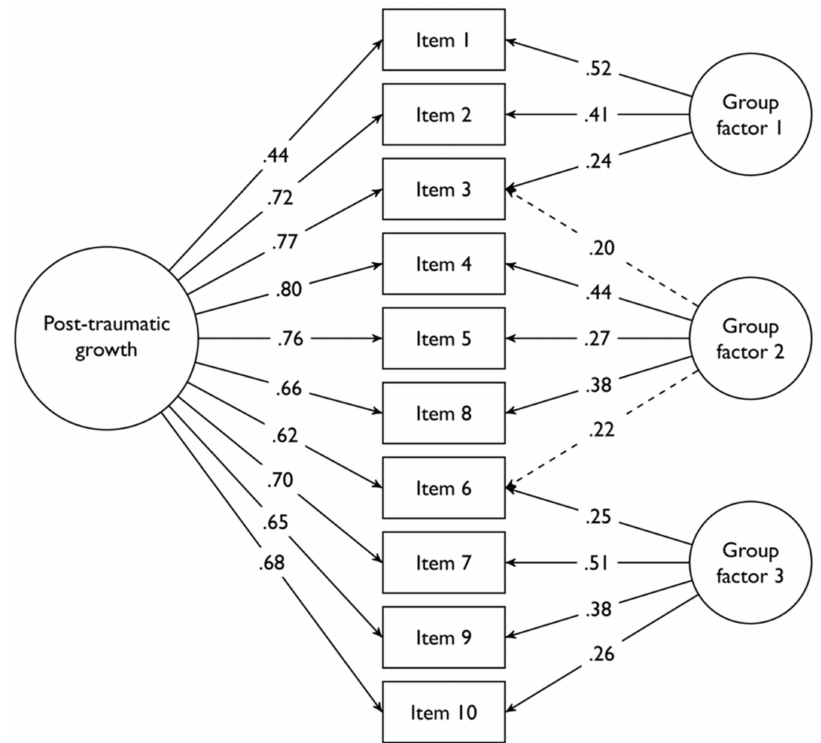
Figure A4. Factor structure resulting from the exploratory bifactor analysis of the Post-Traumatic Growth Inventory-Short Form.